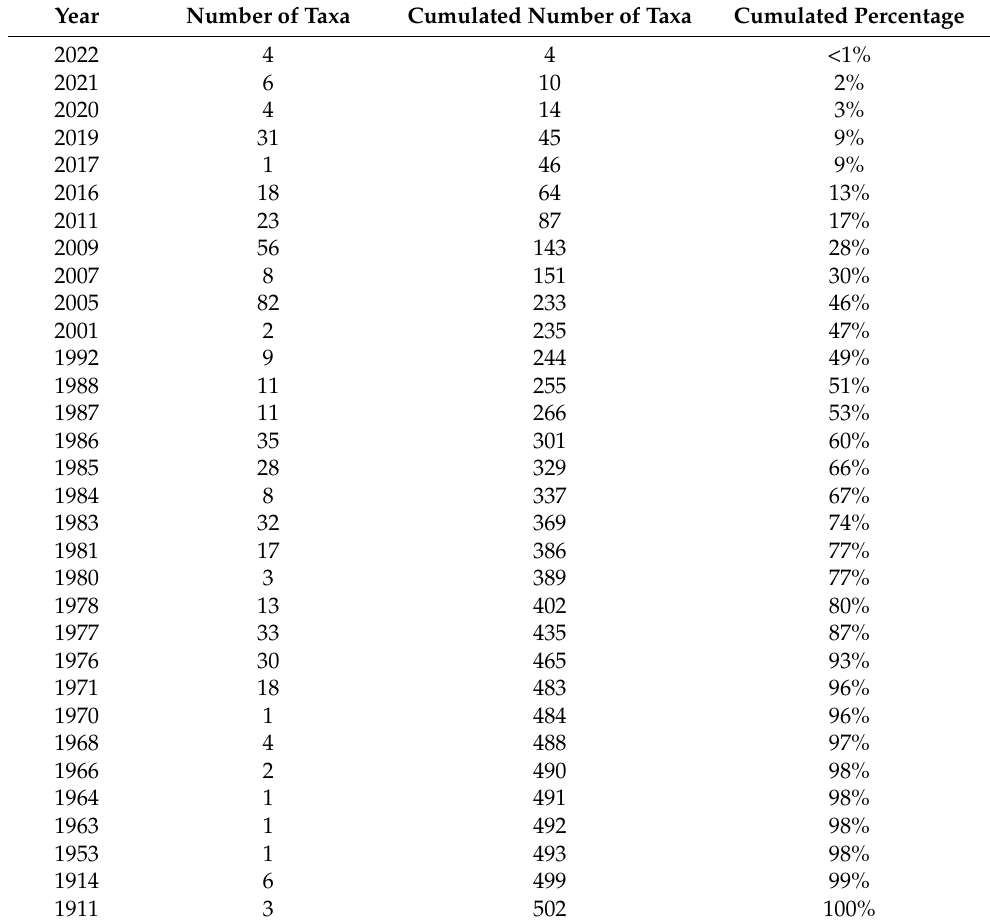
Table 3. Year of the last record for the 502 taxa reported from the